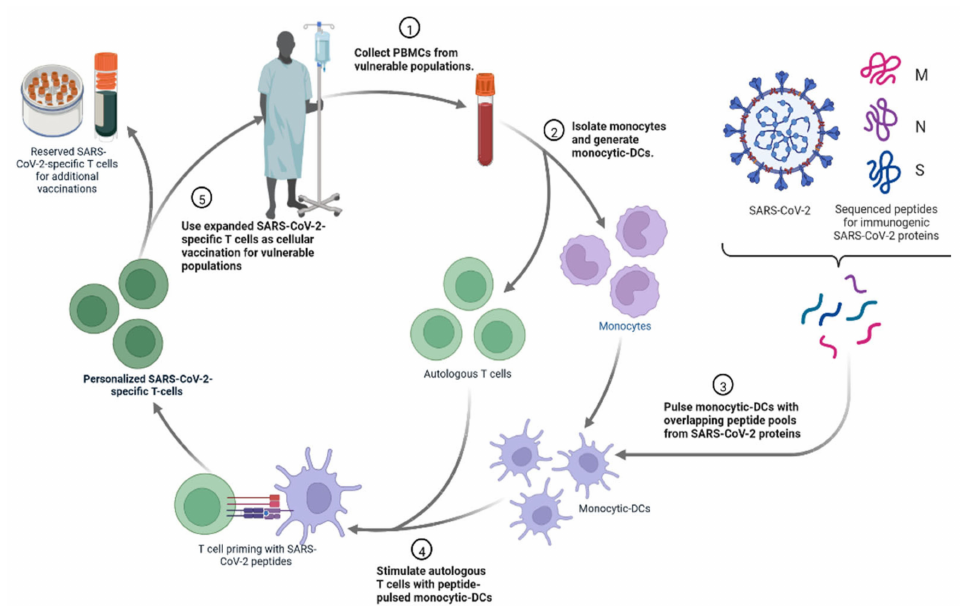
Figure 21. The personalised viral-specific T cells are used as a potential therapeutic to prevent and/or treat SARS-CoV-2 infections.